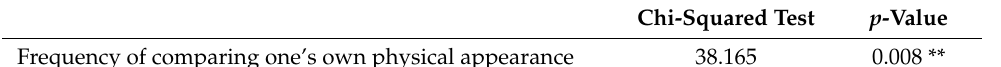
Table 4. Association between level of education and frequency of comparing one’s own physical appearance to that of people followed on social media. Chi-Squared Test p -Value Frequency of comparing one’s own physical appearance 38.165 0.008 **